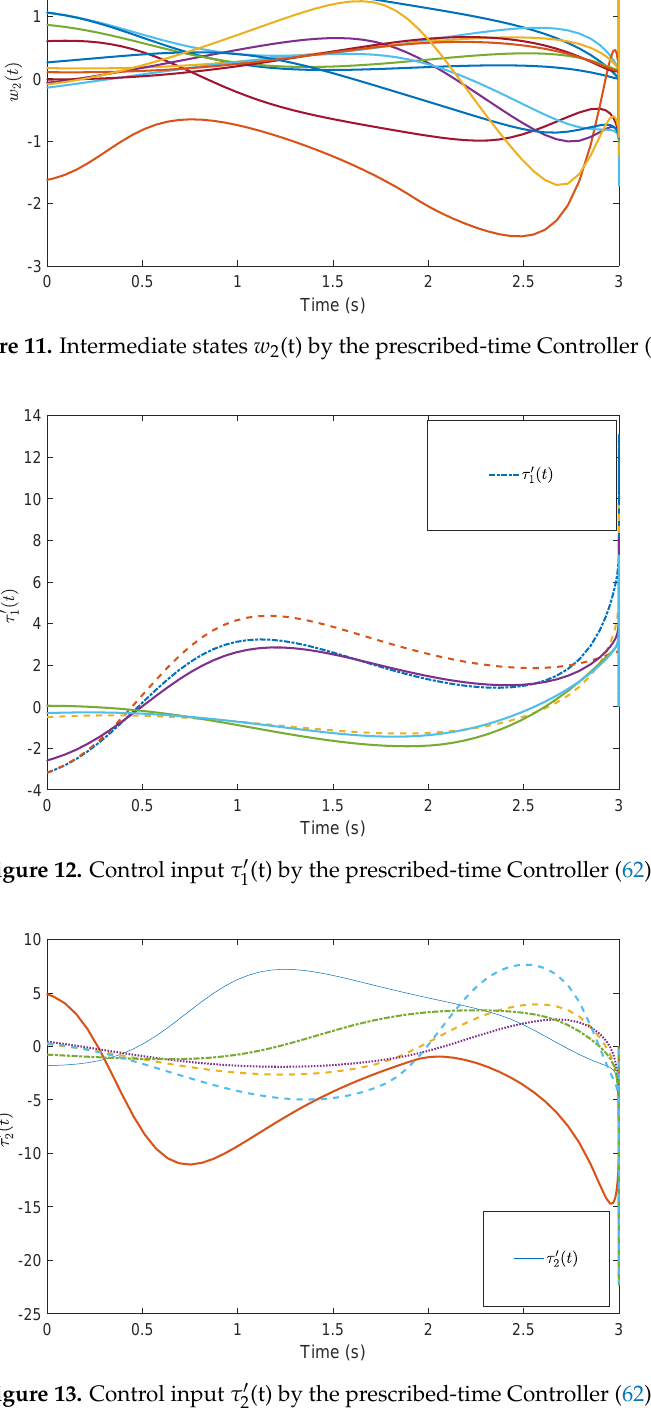
(t) by the prescribed-time Controller 2